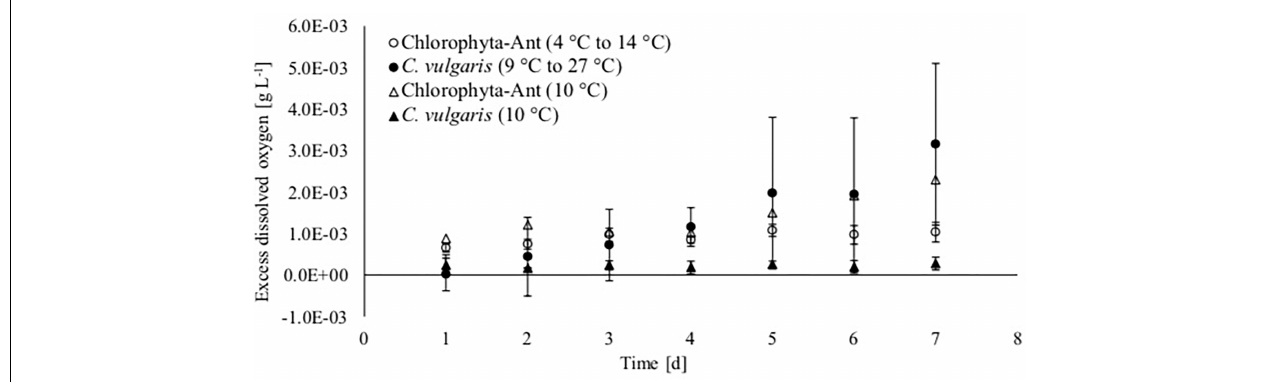
FIGURE 4 | Excess dissolved oxygen based on saturated dissolved oxygen measurements of Antarctic Chlorophyta and temperate Chlorella vulgaris grown in thermal environments of a spacecraft.